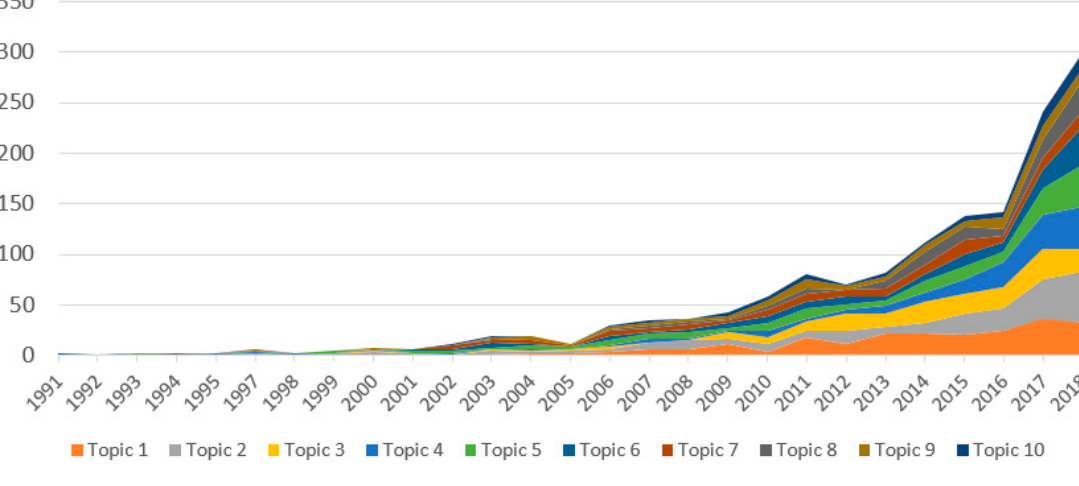
Figure 5. Dendrogram of research areas using the WoS classifications.